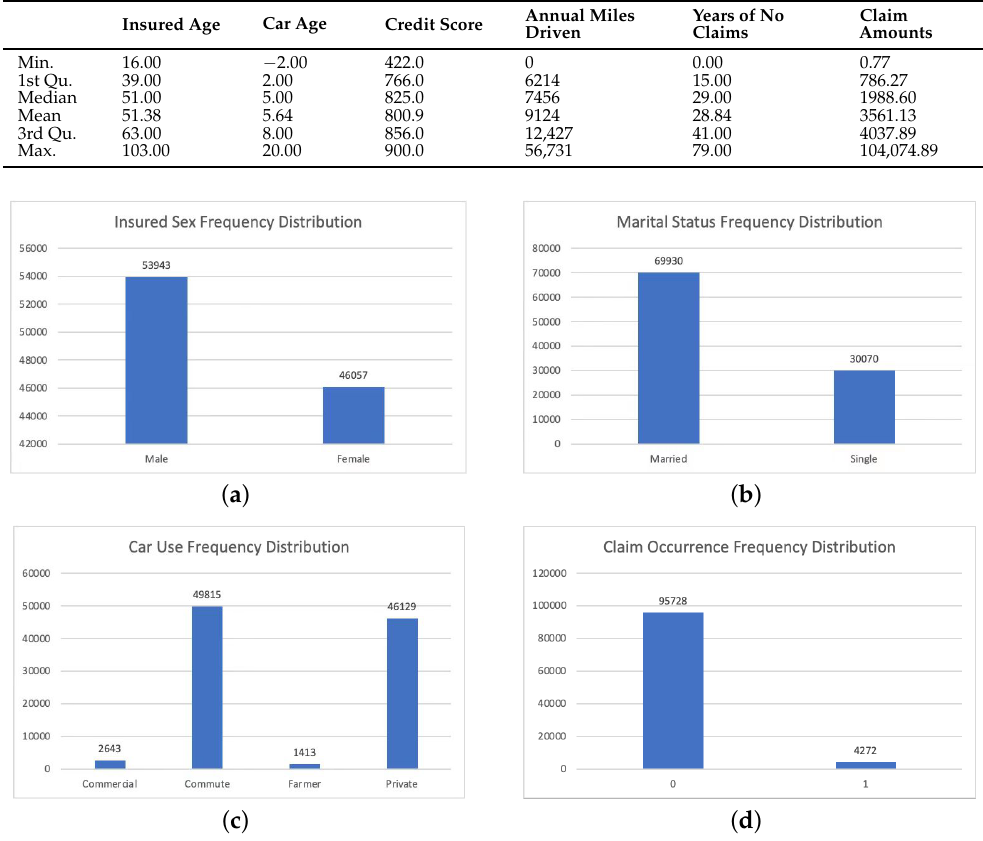
Figure 1. The frequency distributions for categorical variables used in this work, including Insured Sex ( a ), Marital Status ( b ), Car Use ( c ) and Claim Counts ( d ), which is the response variable for model that predicts claim